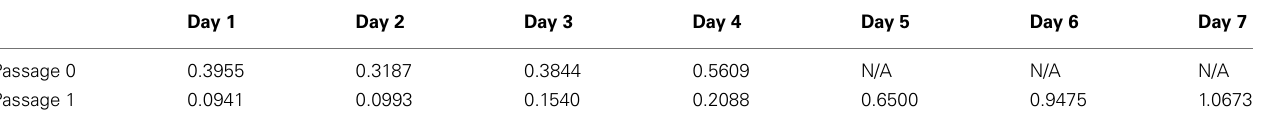
Table 2 | Non-stimulation-induced released GABA concentration in the N2 growth media over time for P0 and P1 embryonic precursor cells ( μ M/20 μ